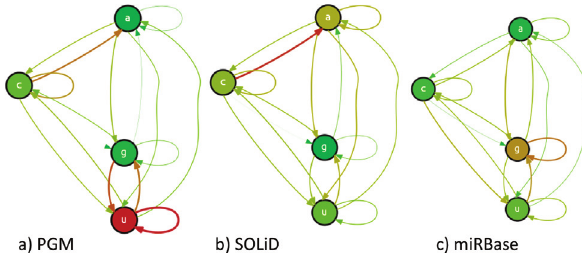
Figure 4 - Overplot of all graphs from the differentially represented miRNAs found in PGM (a) and SOLiD (b), compared to the overall compositional trend of all miRNAs available in miRBase (c). Both size and color of a node or edge describe their weights, where thin green and thick red representations describe the minimum and maximum number of connections each graph, respectively.